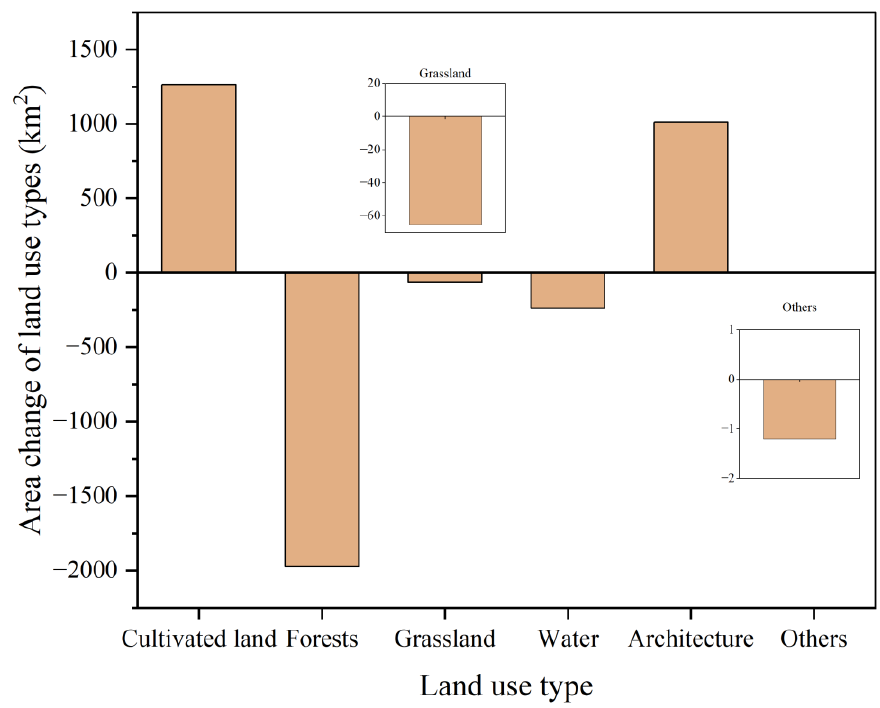
Figure 15. Area changes in land use types in the cultivated land protection scenario from 2020 to 2035.